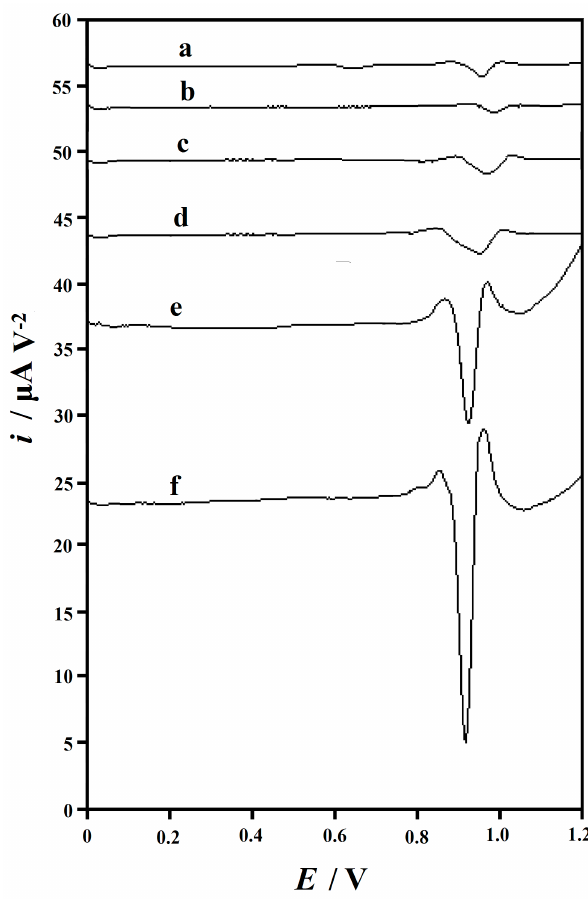
Figure 3. Second-order derivative linear sweep voltammograms of 10 µ M vanillin in 0.1 M H 2 SO 4 solution obtained at different electrodes: ( a ) GCE, ( b ) GO/GCE, ( c ) Cu 2 O nanoparticles (NPs)/GCE, ( d ) Cu 2 O NPs-GO/GCE, ( e ) ERGO/GCE, and ( f ) Cu 2 O NPs-ERGO/GCE. Accumulation potential: 0.0 V, accumulation time: 90 s, scan rate: 0.1 V s − 1 .